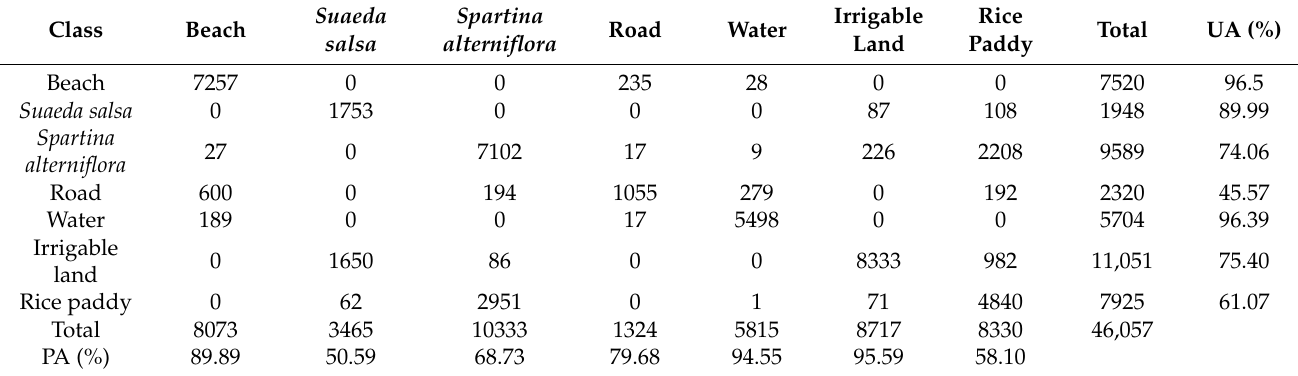
Table 5. Confusion matrix of the classification results from the H/A/Span features set using random forest.